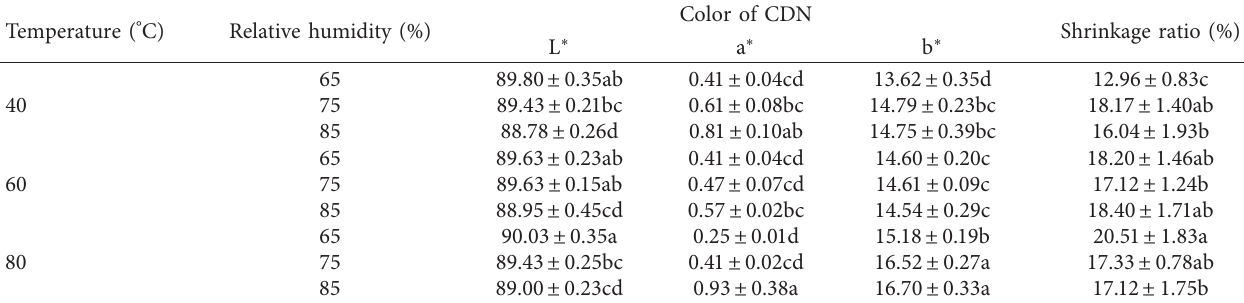
Table 1: Effects of drying temperature and relative humidity on quality characteristics of uncooked CDN.